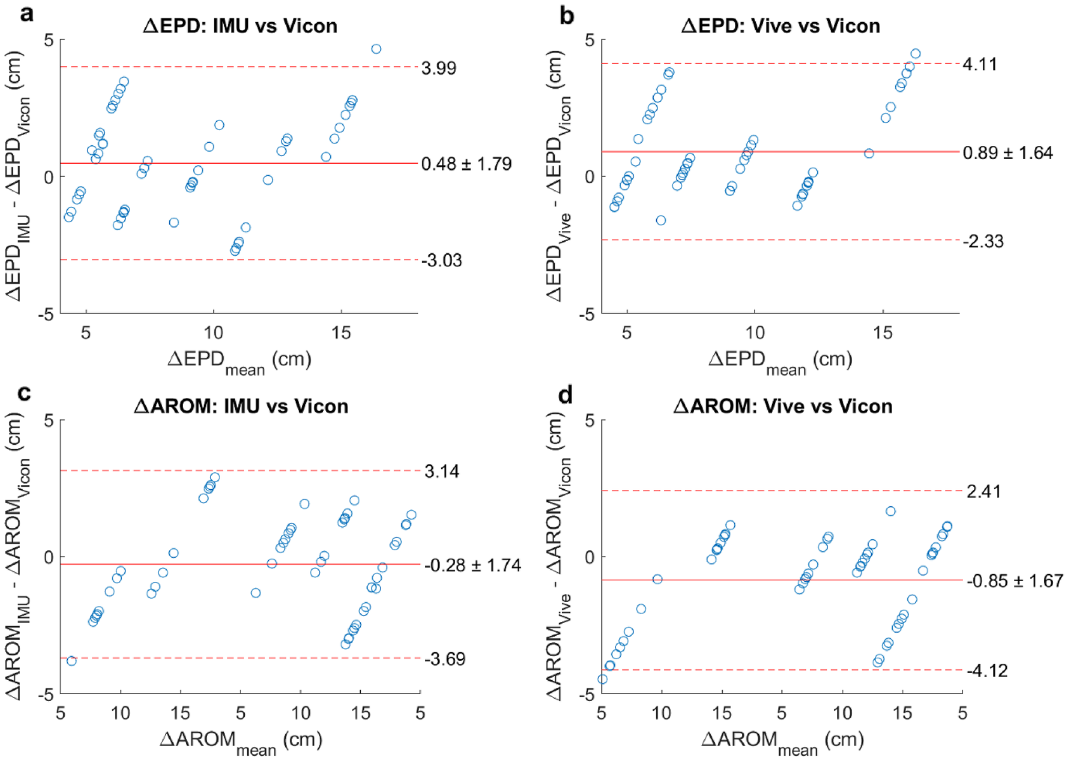
Figure 5. ( a – d ) Changes in endpoint distance (ΔEPD) and active range of motion (ΔAROM) estimated by the IMUs and Vive compared to Vicon estimates, shown as Bland–Altman plots. The changes in EPD and AROM were measured between targets one and two, targets one and three, and targets two and three.